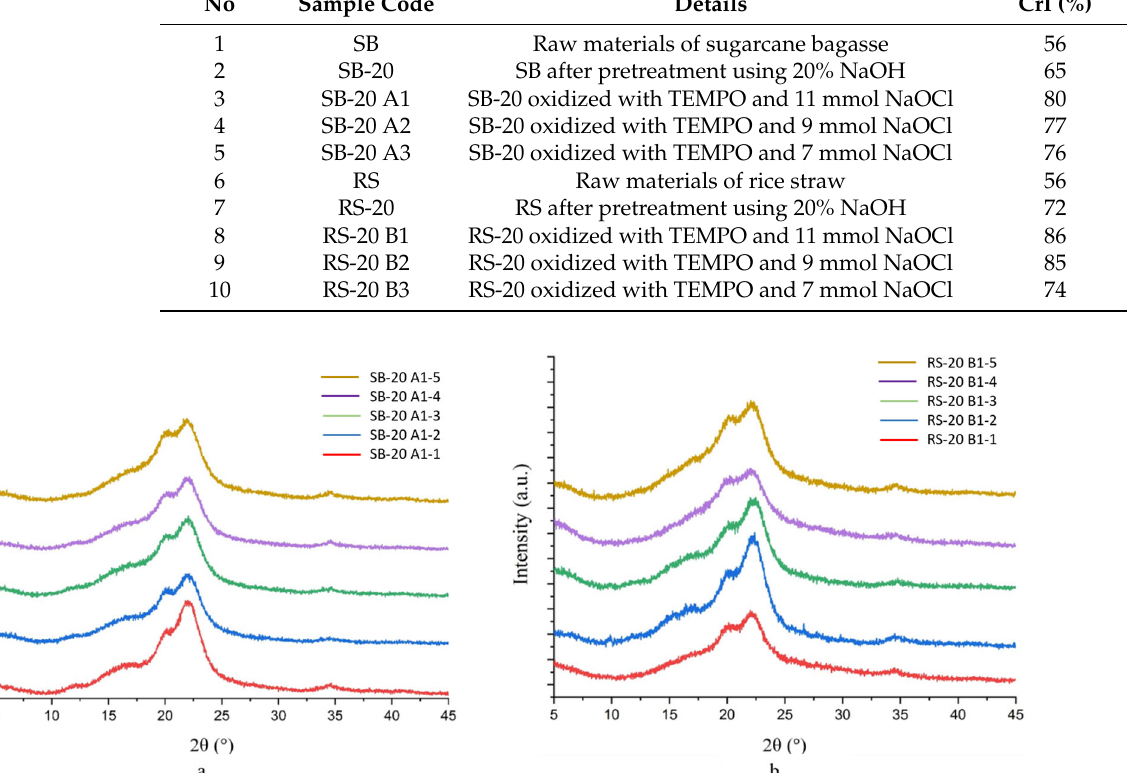
Figure 4. X ‐ ray diffraction patterns of CNC from (a) sugarcane bagasse (SB ‐ 20 A1) and (b) rice straw (RS ‐ 20 B1) after surface modification with various concentrations of CTAB. The last digit in the modified CNC sample code indicates a different CTAB concentration. 1 = 2 mM CTAB; 2 = 4 mM CTAB; 3 = 6 mM CTAB; 4 = 8 mM CTAB; and 5 = 10 mM CTAB.